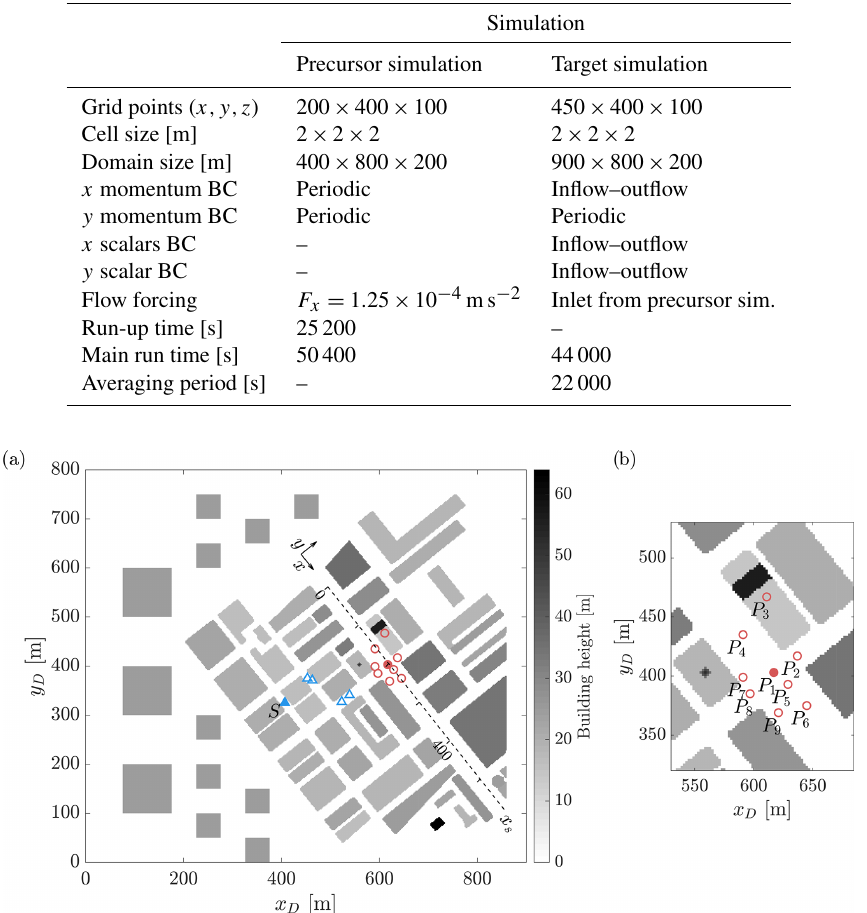
Table 1. Simulation set-up details for precursor and target simulations used in the uDALES validation. Boundary conditions (BCs) are defined for the x and y directions.